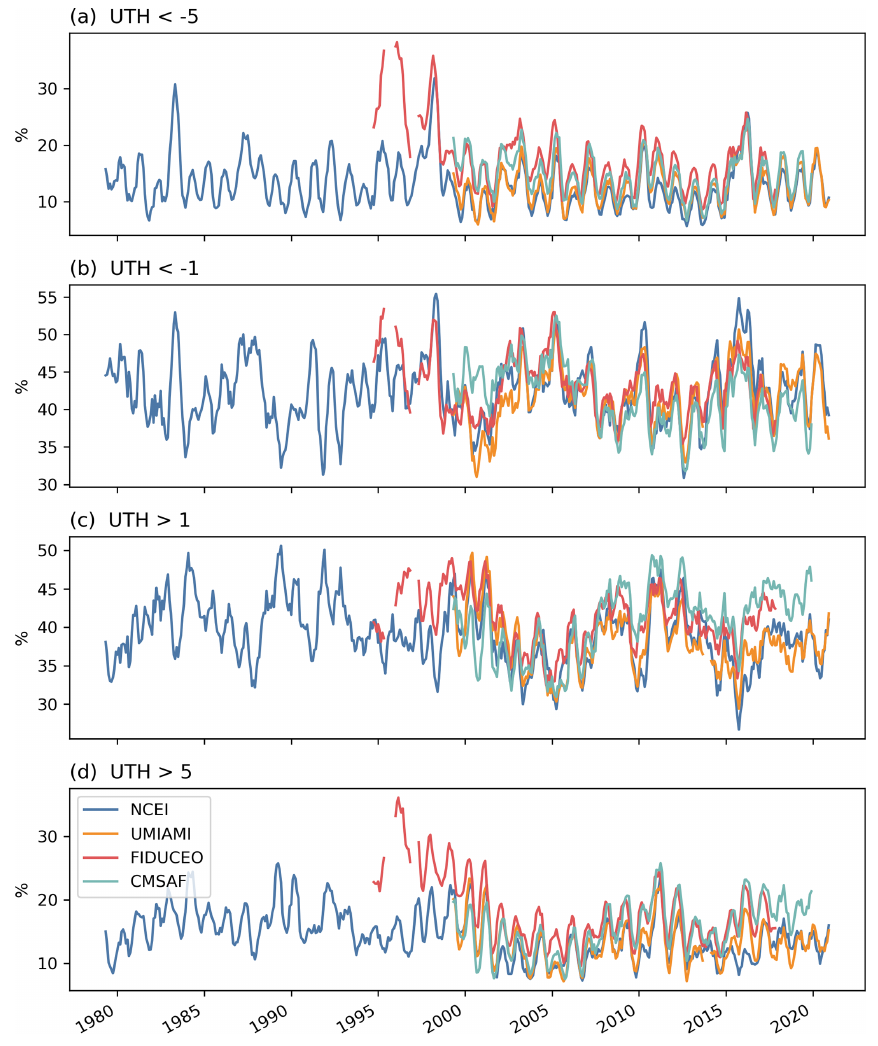
Figure 4. Time series of the proportions of grids over 20 ◦ S–20 ◦ N with anomaly values less than − 5% and − 1% and greater than 1% and